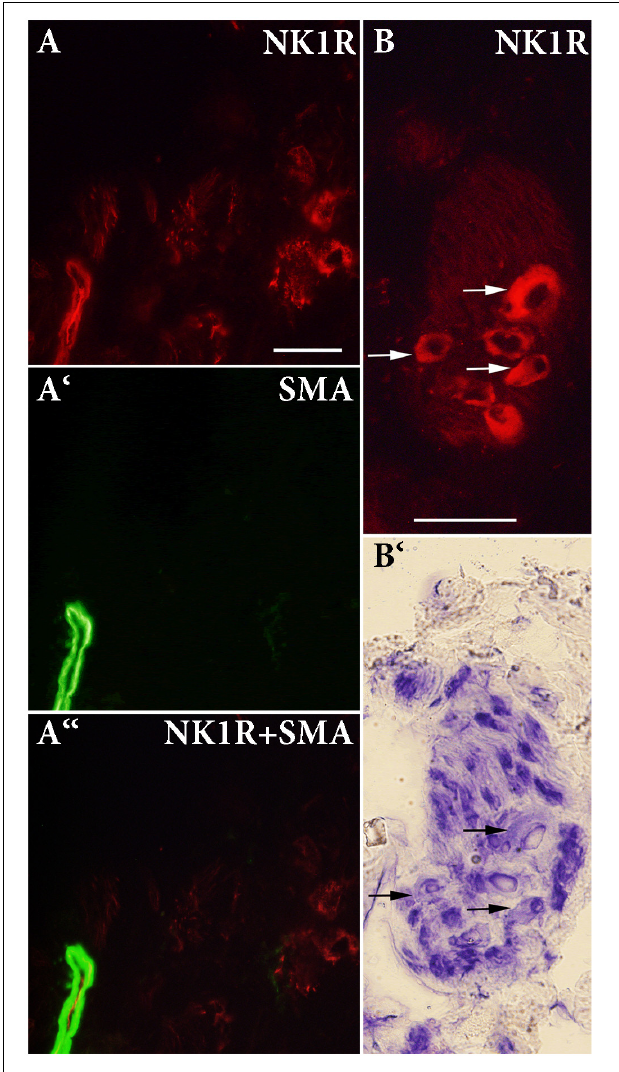
FIGURE 4 | (A,A‘,A“) Double-labeling immunohistochemistry for NK1 receptor (NK1R) and smooth muscle actin (SMA) in the left atrium. A ganglion containing large-diameter neurons is shown. NK1R immunoreactivity (IR) is detected on the majority of intracardiac neurons and in smooth muscle cells. (B,B‘) IR for NK1R and histochemical staining of a neighboring frozen section to verify localization of NK1R-IR. NK1R-IR is seen in large-diameter neurons (arrows). Bar = 50 µ